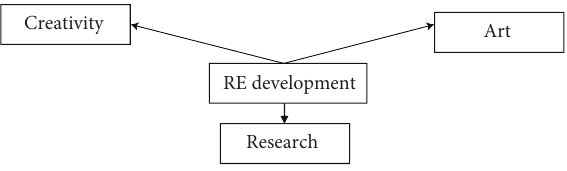
Figure 1. Real estate development consists of